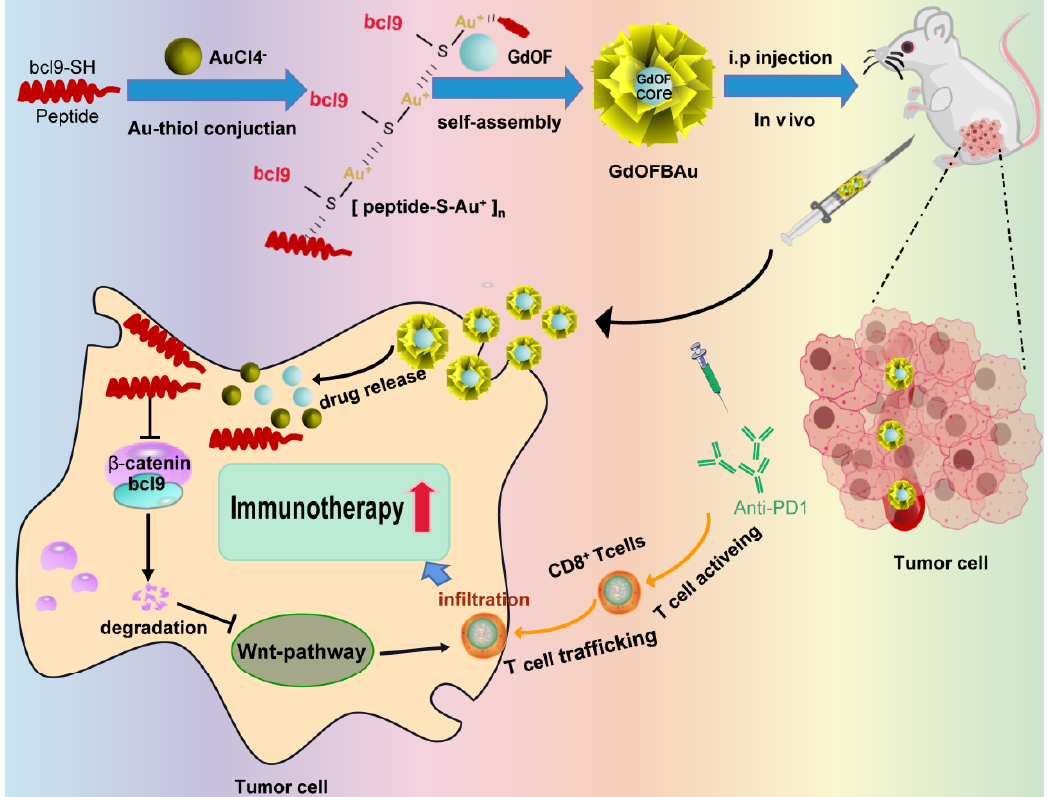
Figure 1. Schematic diagram of the preparation of GdOFBAu and its action.